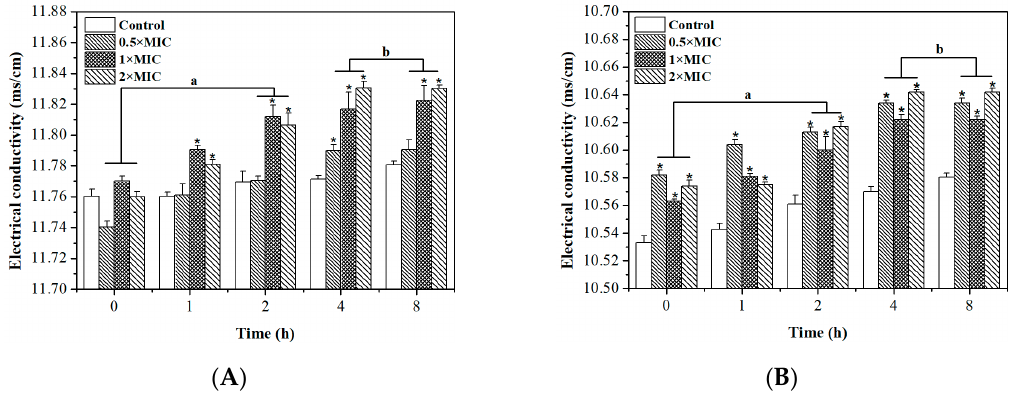
Figure 5. The effects of DMY on the permeability of S. aureus ( A ) and E. coli ( B ). * p < 0.05 versus the control group. a There was a significant difference between two intervals ( p < 0.05). b There was no significant difference between the two intervals ( p > 0.05).